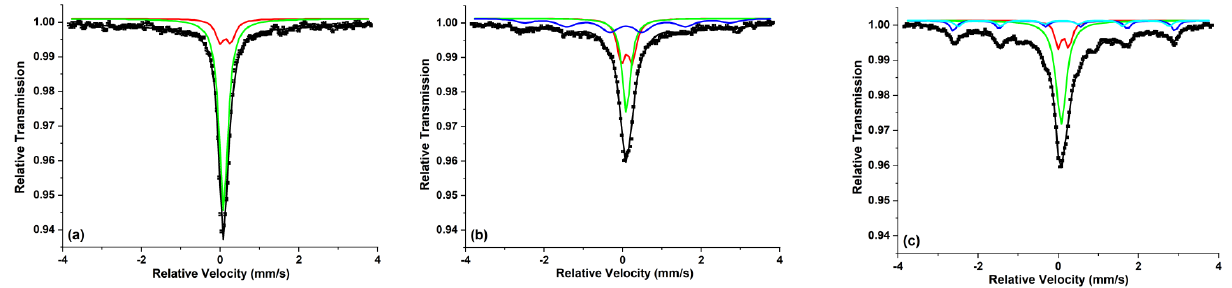
Figure 4. The 4.2 K 57 Fe Mössbauer spectra of the Fe:PVA (2 wt% FeCl 3 ) films with: ( a ) 5 wt% PVA, ( b ) 8 wt% PVA, ( c ) 11 wt% PVA.